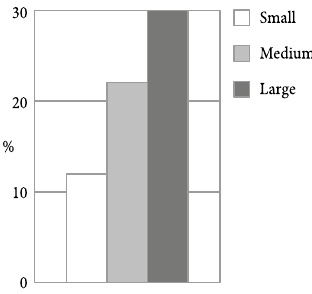
Fig. 2. The percentage of firms that use bank financing for new investments Source: Own simulation based on the data provided by International Finance Corporation (2010: